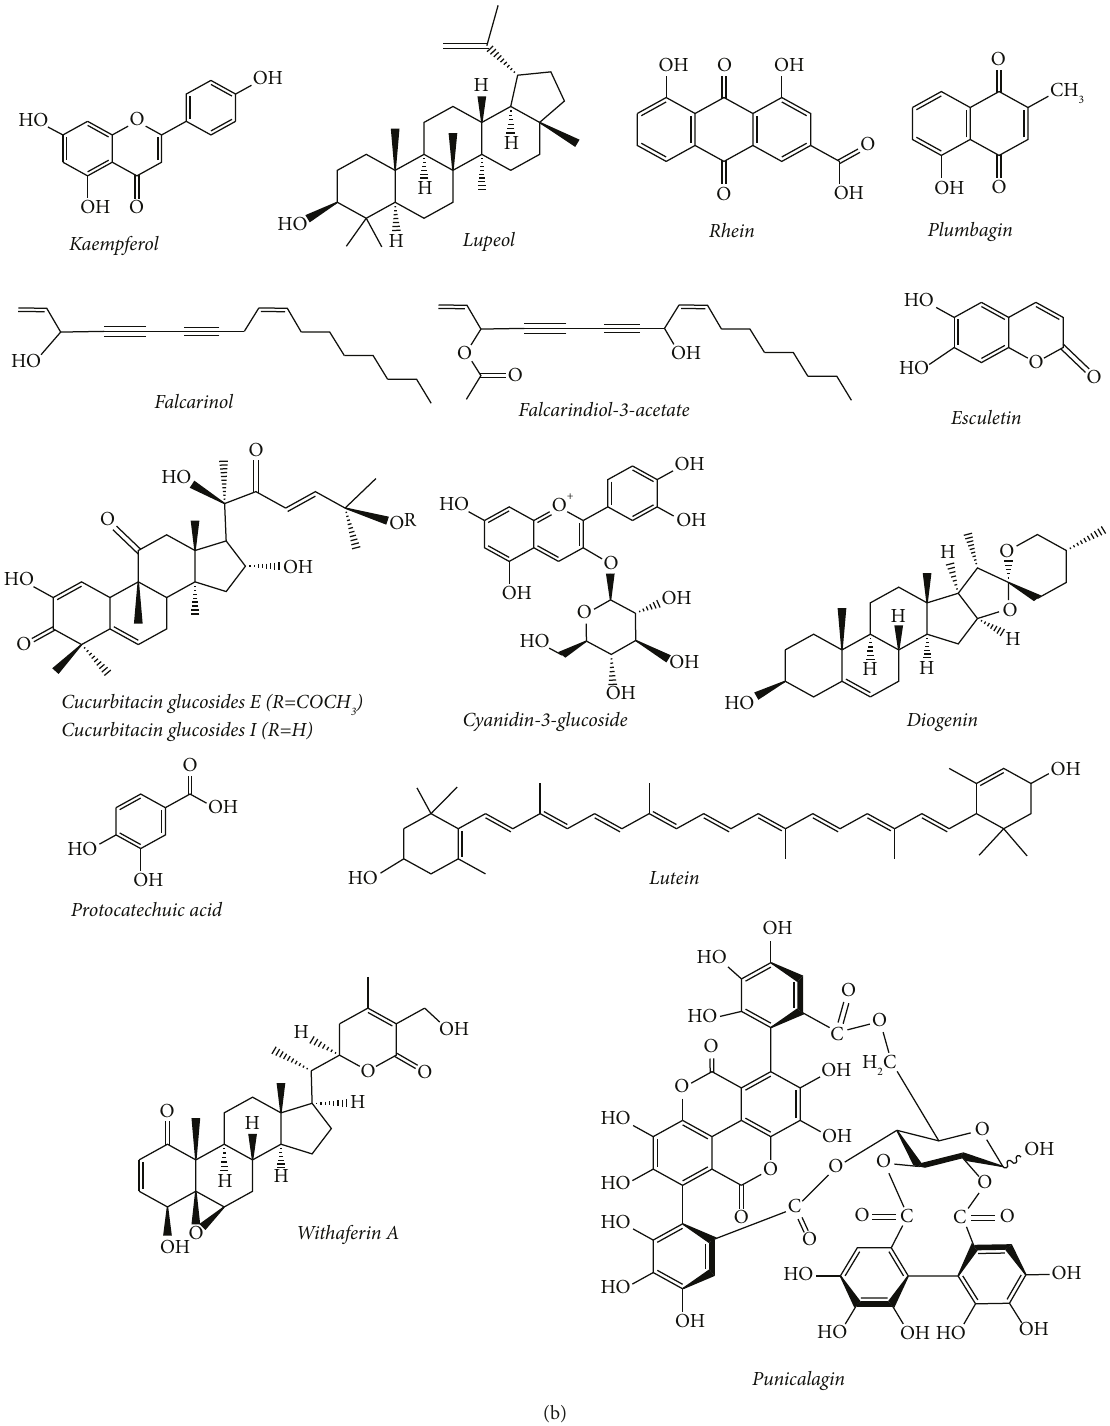
Figure 2: Compounds having anticancer